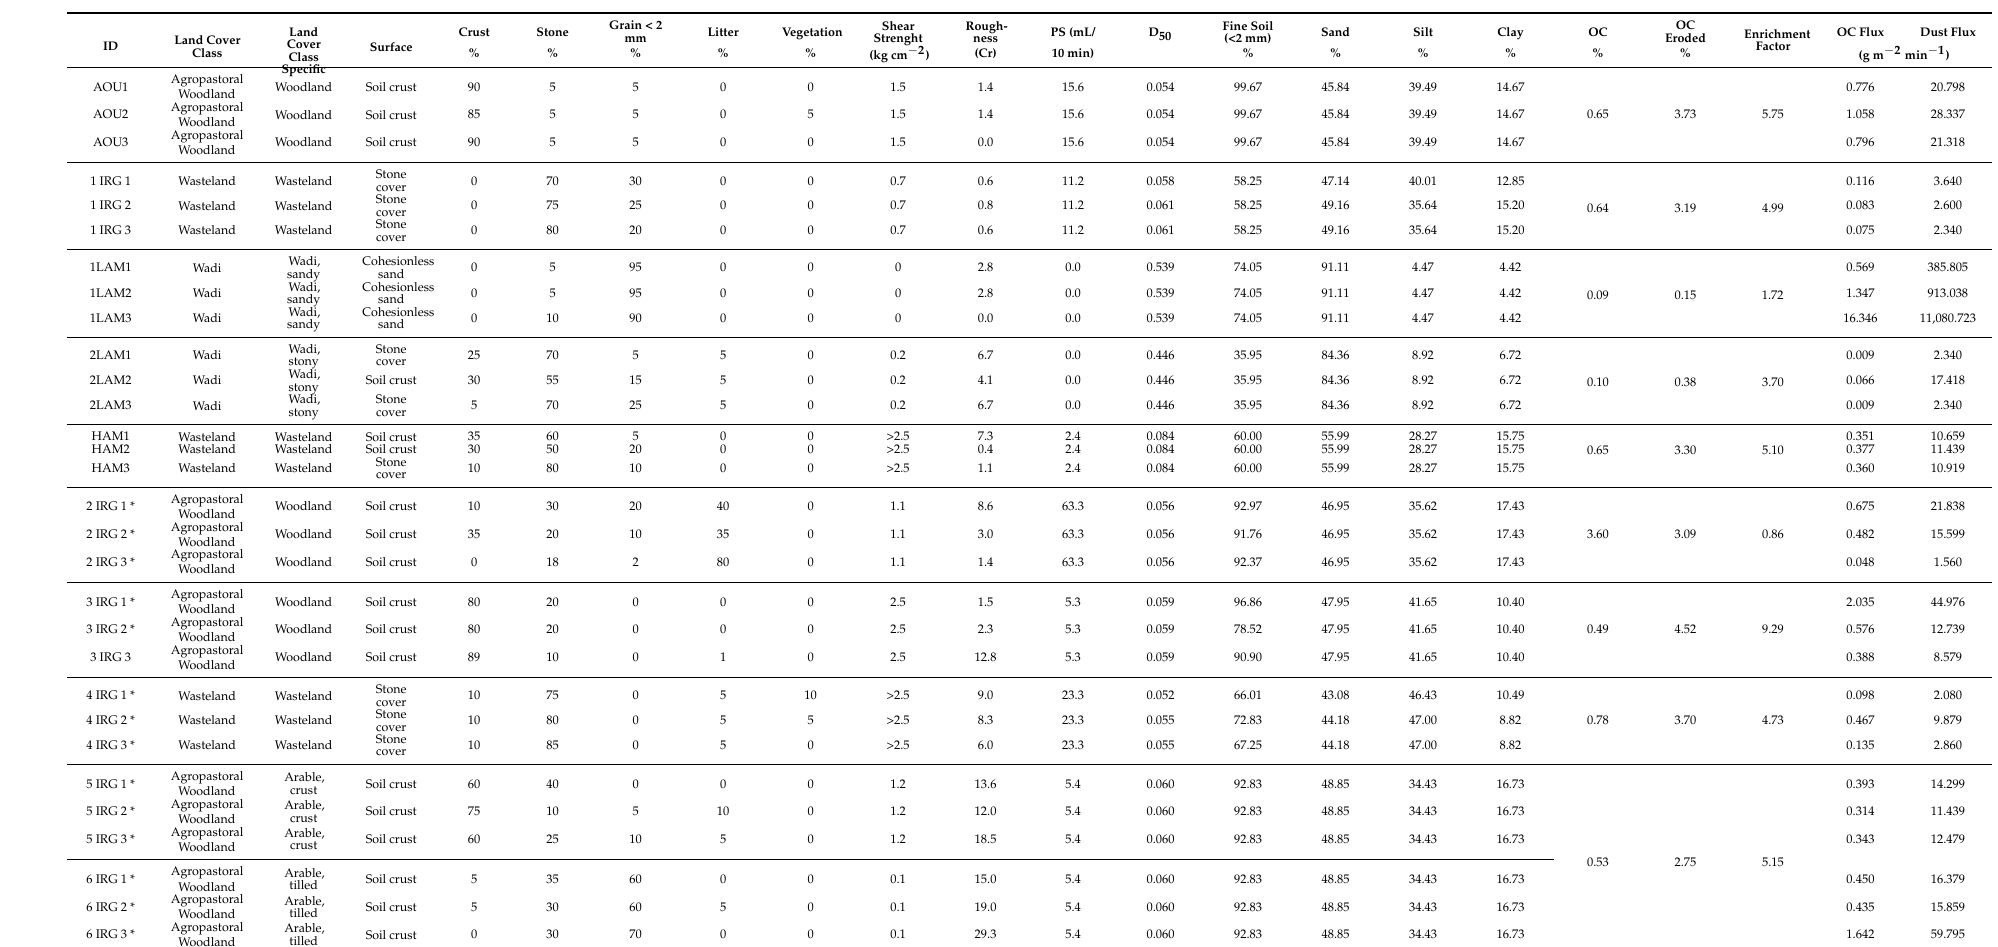
Table 1. Soil and surface